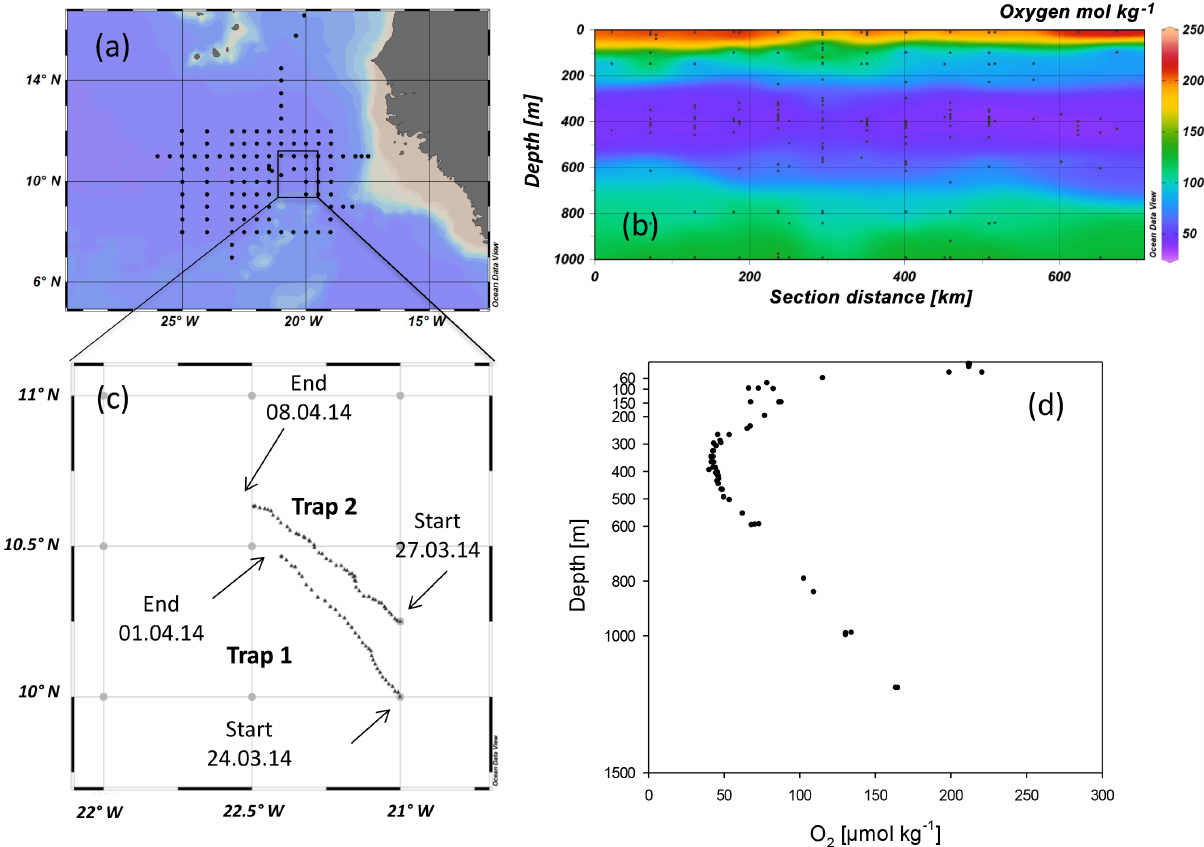
Figure 1. Map of (a) the study area and (b) depth distribution of oxygen concentration (molkg − 1 ) in the eastern tropical North Atlantic (ETNA) during the RV Meteor 105 cruise, when two surface-tethered drifting sediment traps (STDT) were deployed (c) . Depth distribution of oxygen concentration (molkg − 1 ) at stations visited in the deployment area showed an oxygen minimum zone in the upper mesopelagic (d)